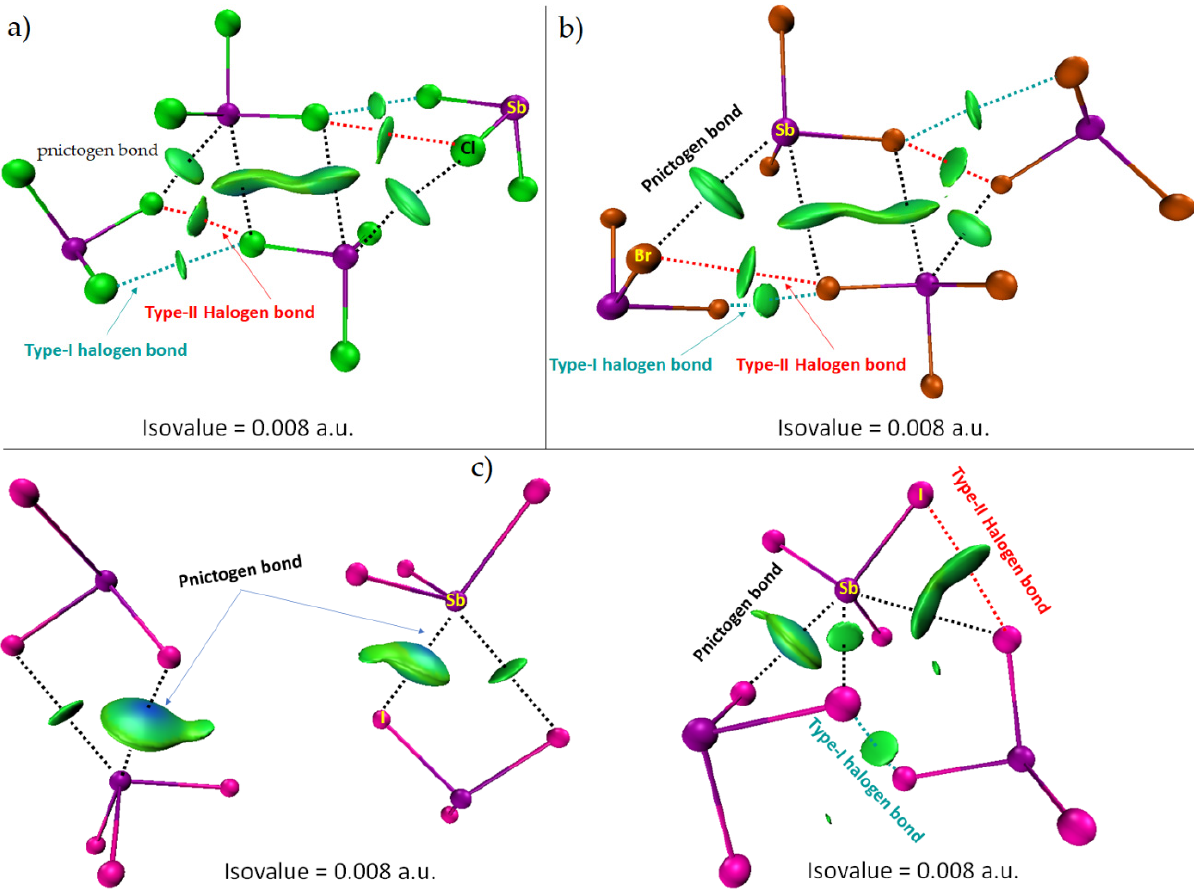
Figure 11. ( a ) IGM- δ g based isosurfaces (green and bluish-green volumes between atomic basins) between the molecular entities responsible for the unit-cells of SbX 3 (X = Cl, Br, I) crystals: ( a ) SbCl 3 ( Pbnm ); ( b ) SbBr 3 ( Pbnm ); and ( c ) SbI 3 ( P2 1 /c ). An isovalue of 0.008 a.u. was used on all occasions. The nature of specific intermolecular interactions is shown for each case, and are marked by arrows. Atom type is also shown for all cases. Atoms are shown as small spheres and bonds as lines in atom color, whereas the intermolecular interactions are represented by dotted lines.